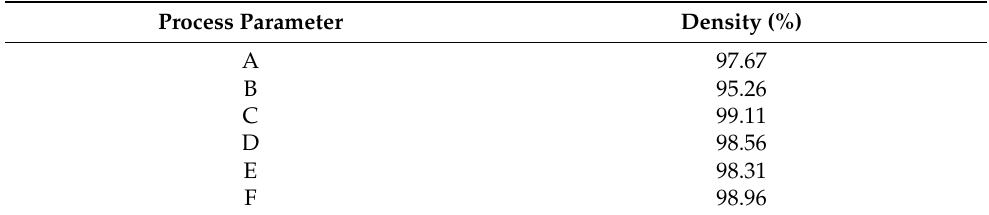
Table 5. Results of the density measurements of Modification I specimens, done with image process- ing. The process parameters used are listed in Table 2.